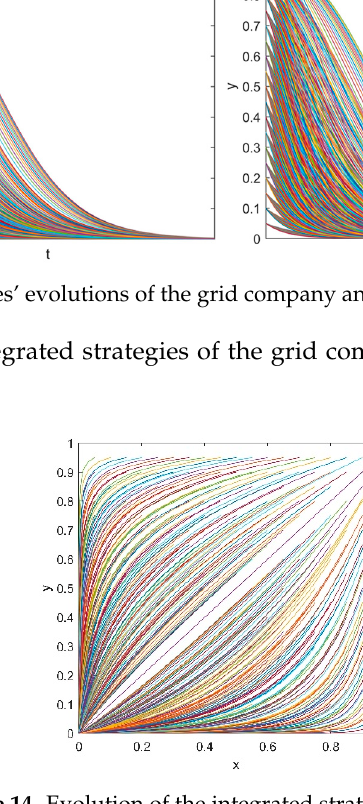
Figure 12. Analysis of the evolution process in Case 4. ( a ) Power grid companies; ( b ) users; and ( c ) power grid companies and users.